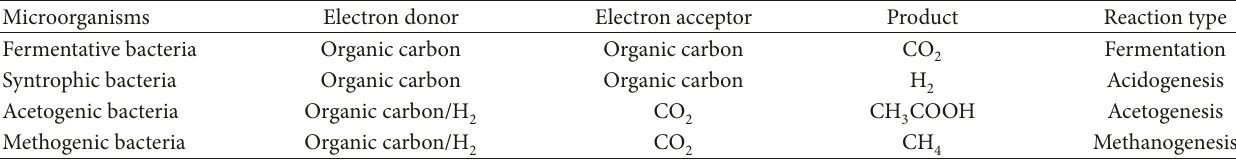
Table 1: Microbial cooperation in organic matter degradation